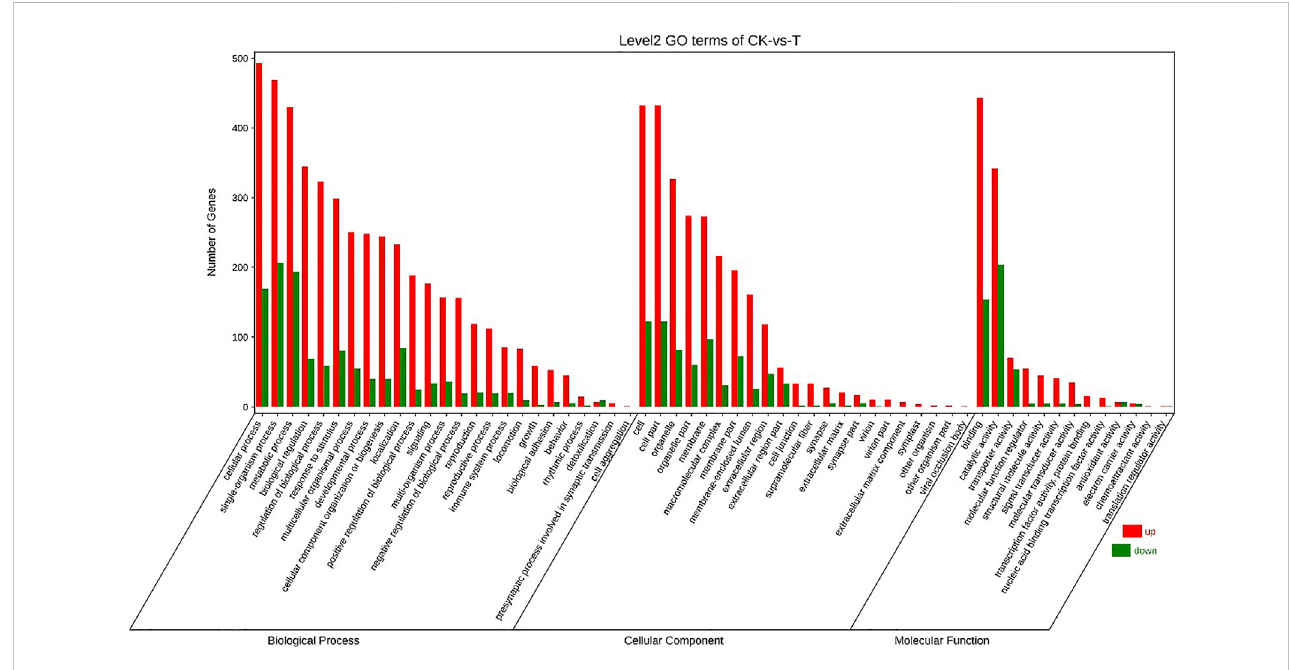
GO classi fi cation of